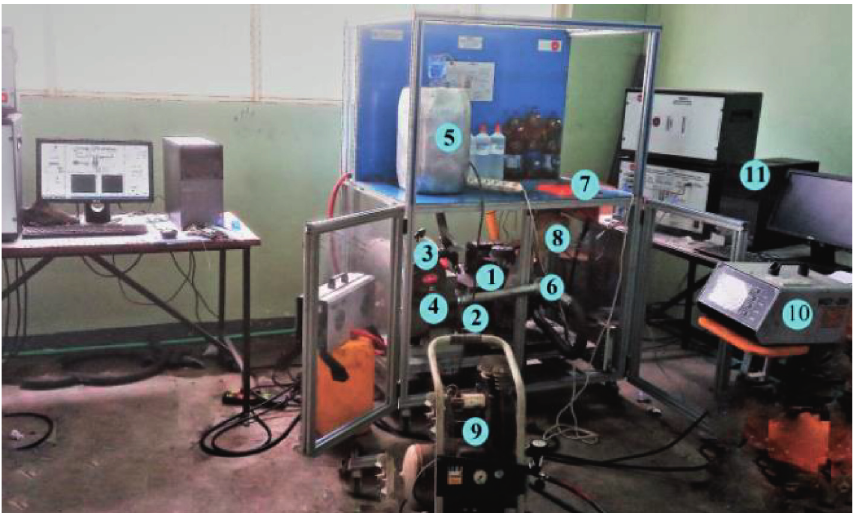
Figure 1: Experimental setup of the PCCI-DI single-cylinder diesel engine. (1) One cylinder engine; (2) motor; (3) EGR cooler; (4) EGR valve; (5) water reservoir; (6) intake port; (7) dieseline reservoir; (8) methanol reservoir; (9) air compressor; (10) smoke meter; (11) control system with a computer.